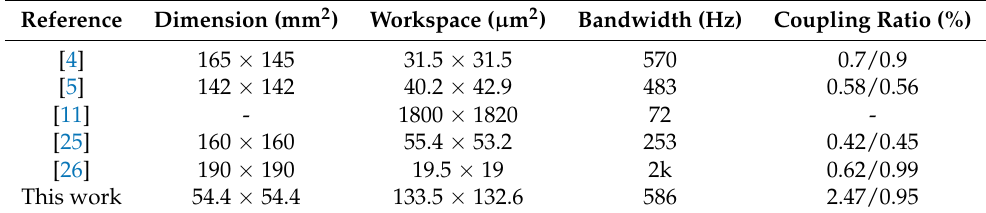
Table 2. Performance comparison with state-of-the-art dual-axial